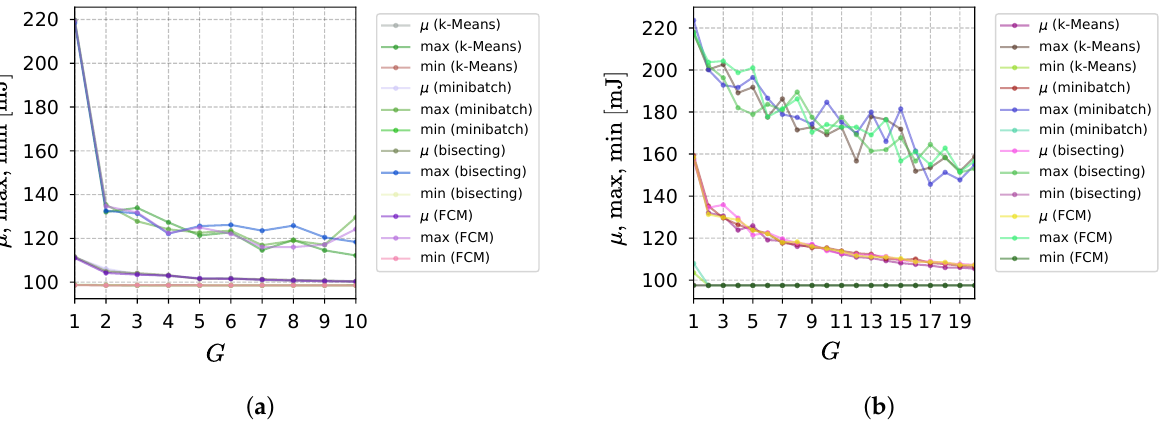
Figure 11. Energy metrics evolution as a function of the number of GWs obtained by the method considering ( a ) Scenario 1, and ( b ) Scenario 2.